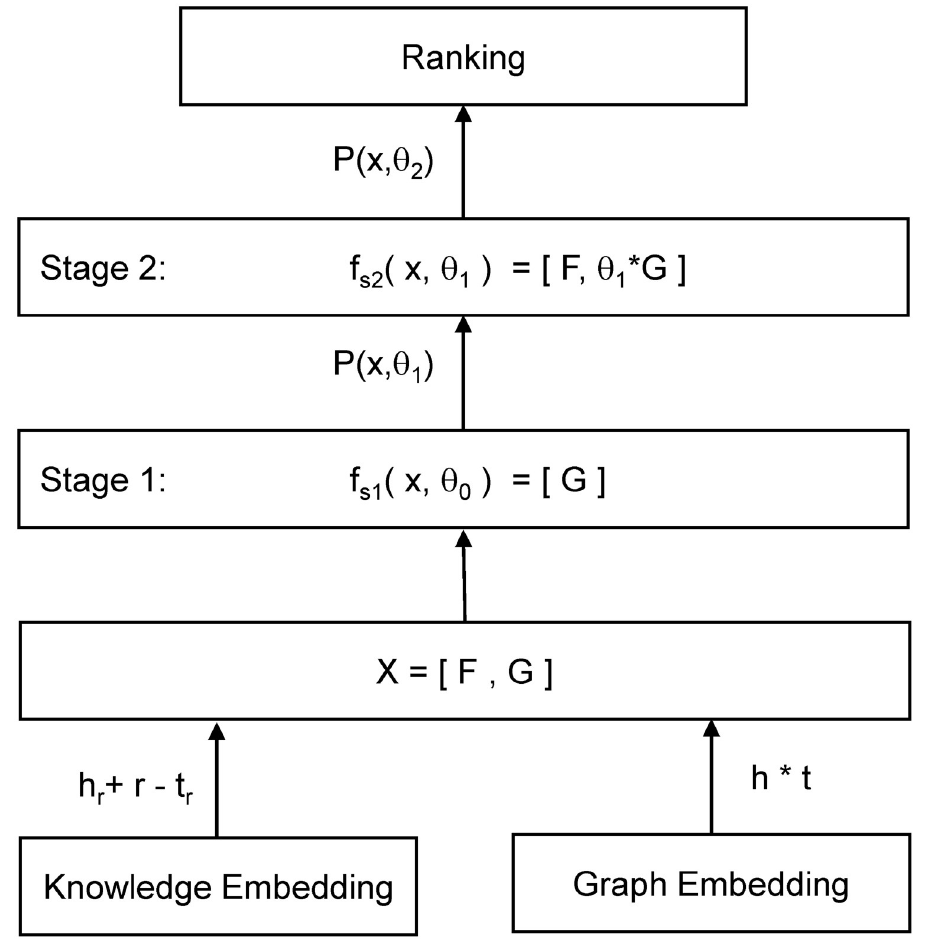
Fig 4. The framework of knowledge embedding cascade